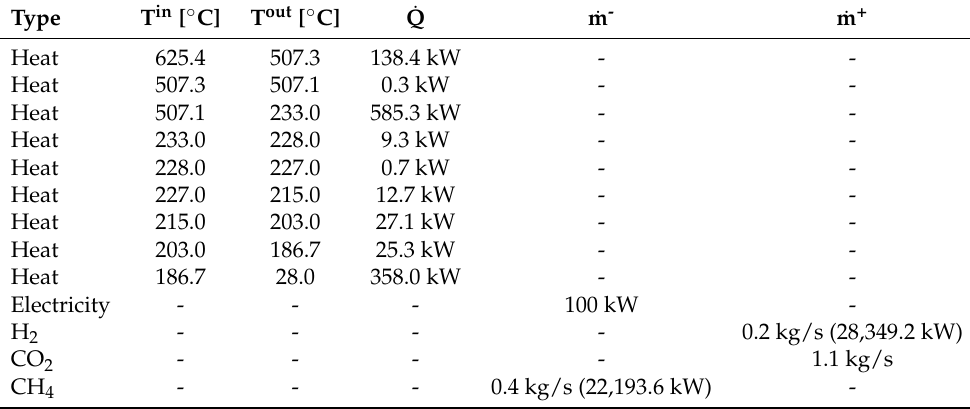
Table A11. Streams for methanation